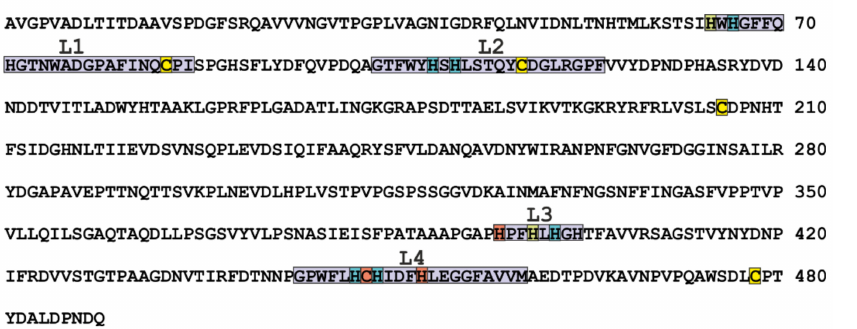
Figure 2. Amino acid sequence of T. hirsuta LacA laccase (gb | KP027478.1). The L1-L4 regions are shown in purple, the copper ion Cu1 ligands are shown in orange, Cu2—in green, and Cu3—in blue. Cysteine residues that are involved in the formation of disulfide bonds are shown in